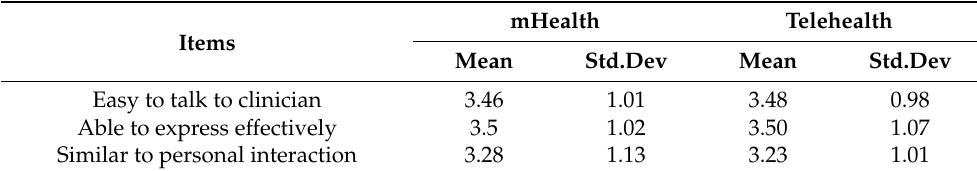
Table 8. Interaction quality of mHealth and